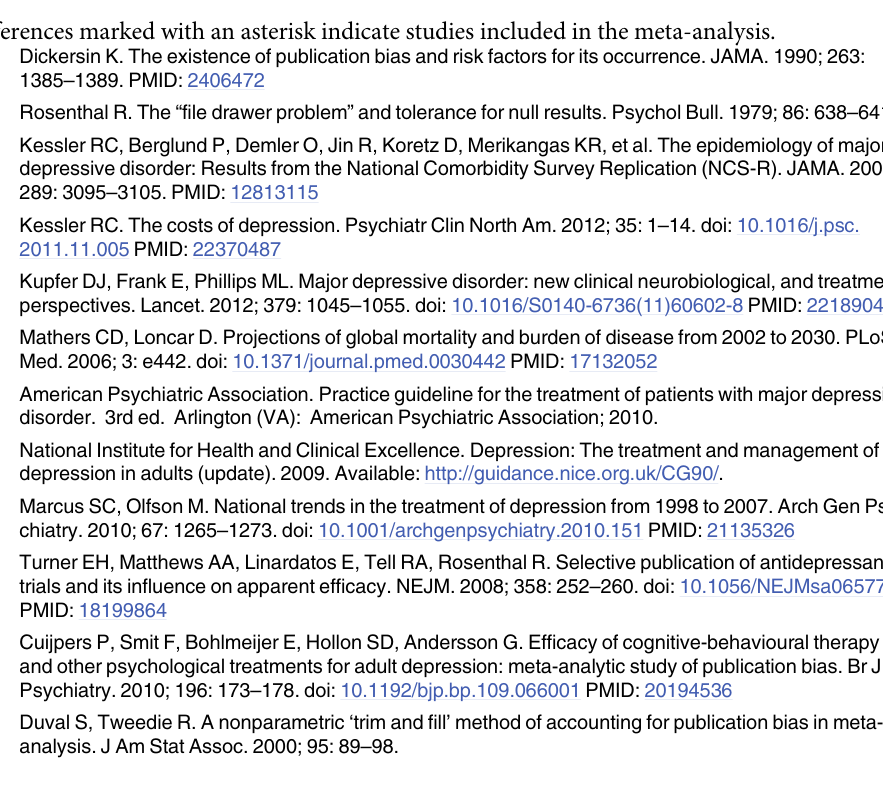
S1 Table. Meta-analyses of studies examining the effect of psychological treatment for depression (Additional and sensitivity analyses). (cid:1) p < .05; (cid:1)(cid:1) p < .01; Italic numbers indicate a non-significant trend ( p < .10). a difference between the effect size point estimates of the pub- lished studies only and the published + unpublished studies, calculated using 5 decimals. b 1 degree of freedom. c Sensitivity analysis changing psychotherapy ranks in the published study, which was intended to minimize allegiance effects [47]. d Sensitivity analysis counting [39] that does not report effect size data as unpublished. e Sensitivity analysis including the unpublished Gottlieb study, for which the effect size was estimated to be zero because of missing data. Note: = number of studies; PT = psychological treatment; Q . = Q between N St betw